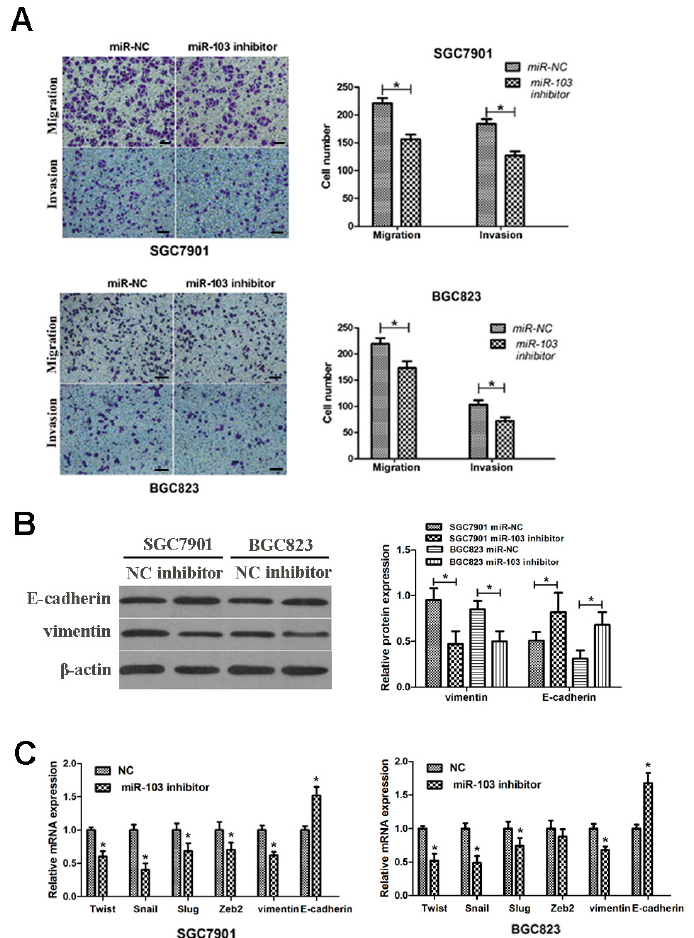
Figure 3. miR-103 promotes cell migration, invasion and mesenchymal-epithelial transformation (EMT) of GC cells. ( A ) Effect of miR-103 knockdown on cell migration and invasion ability in SGC7901 and BGC823 cells, Scale bar = 50 µ m; ( B ) E-cadherin and vimentin expression in SGC7901 and BGC823 cells by western blot and ( C ) epithelial-to-mesenchymal transition (EMT)–associated genes expression in SGC7901 and BGC823 cells by RT-qPCR. * p < 0.05; the data represent the mean ± SD from triplicate measurements.